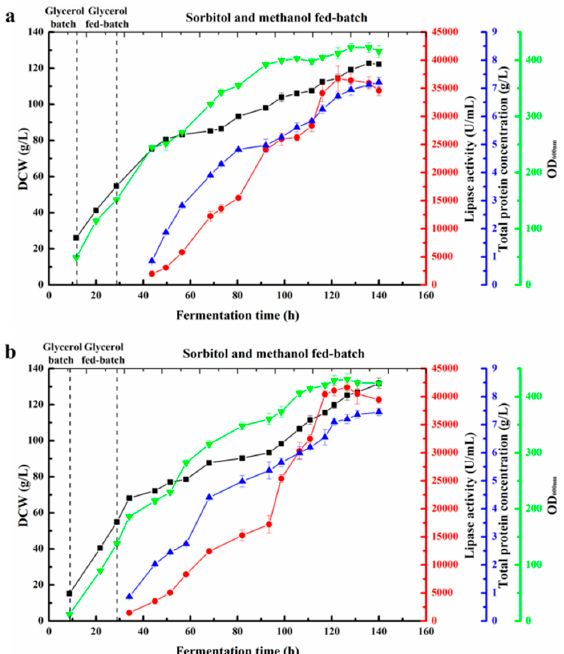
Figure 4. Time course of dry cell weight (DCW) (black square), ROL activity (red circle), total protein concentration (blue triangle), and optical density at 600 nm (OD 600nm ) (green inverted triangle) during a 3 L high-density fermentation of the strains ( a ) GS115/5ROL-Ssa4-Sso2-Bmh2 4# and ( b ) GS115/5ROL-Ssa4-Sso2-Bmh2-VHb 9#. Data represent the mean ± standard deviation of three independent experiments.